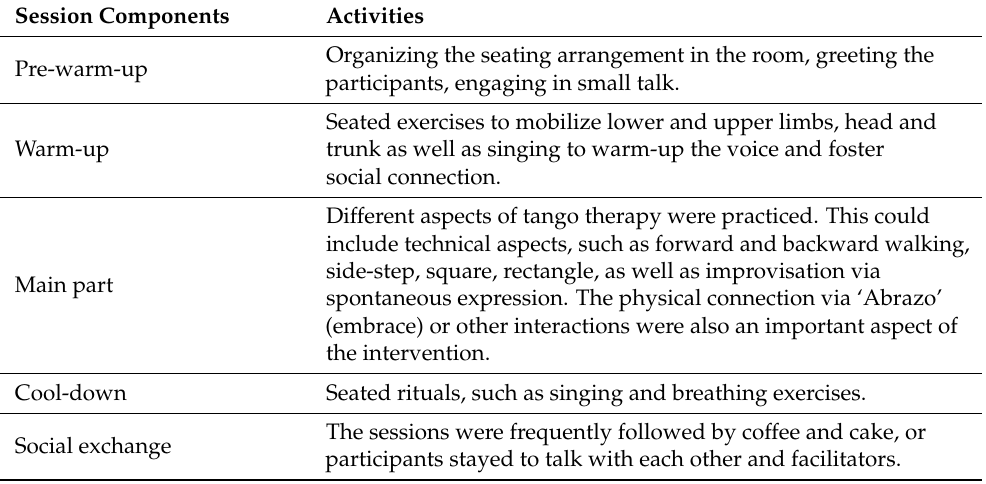
Table 1. Overview of session content.